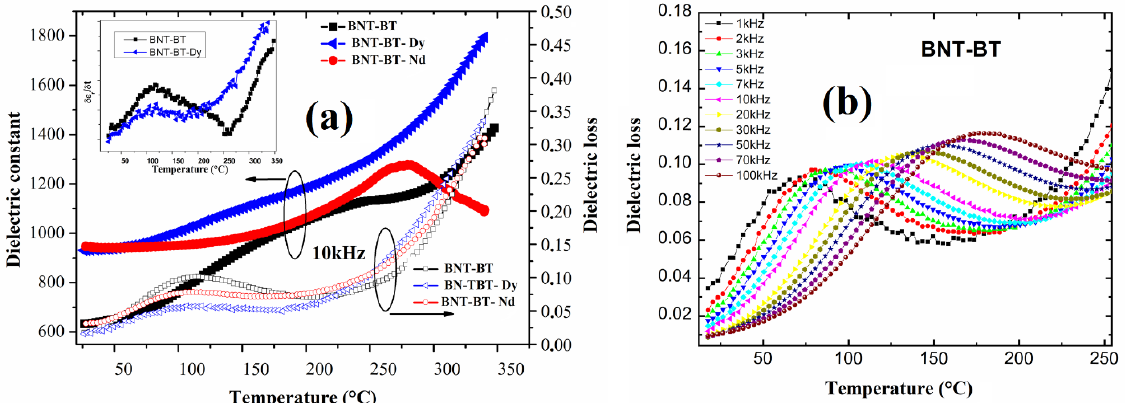
Figure 5. ( a ). Variation in the dielectric constant and the dielectric loss as a function of temperature for the investigated samples. The inset shows the derivative of the dielectric constant versus temperature for BNT-BT and BNT-BT-Dy compositions, and ( b ) an example of frequency dependence of the thermal variation in the dielectric loss for BNT-BT thin films.